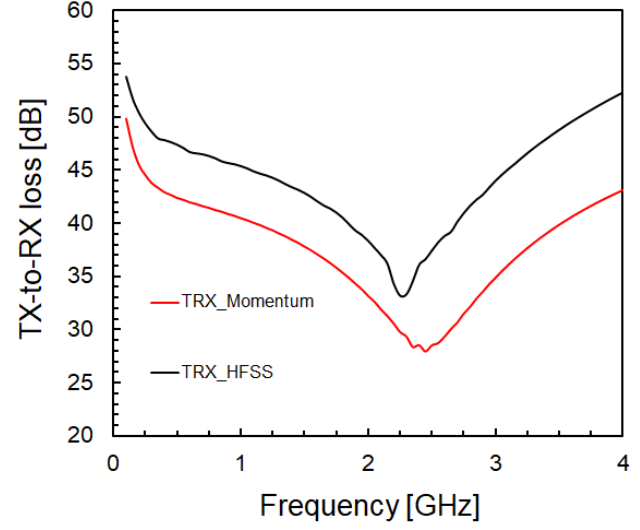
Figure 11. Comparison between HFSS and ADS Momentum: TRX for RF coupled antennas on a high conductive substrate ( σ S = 5 × 10 4 S/m).